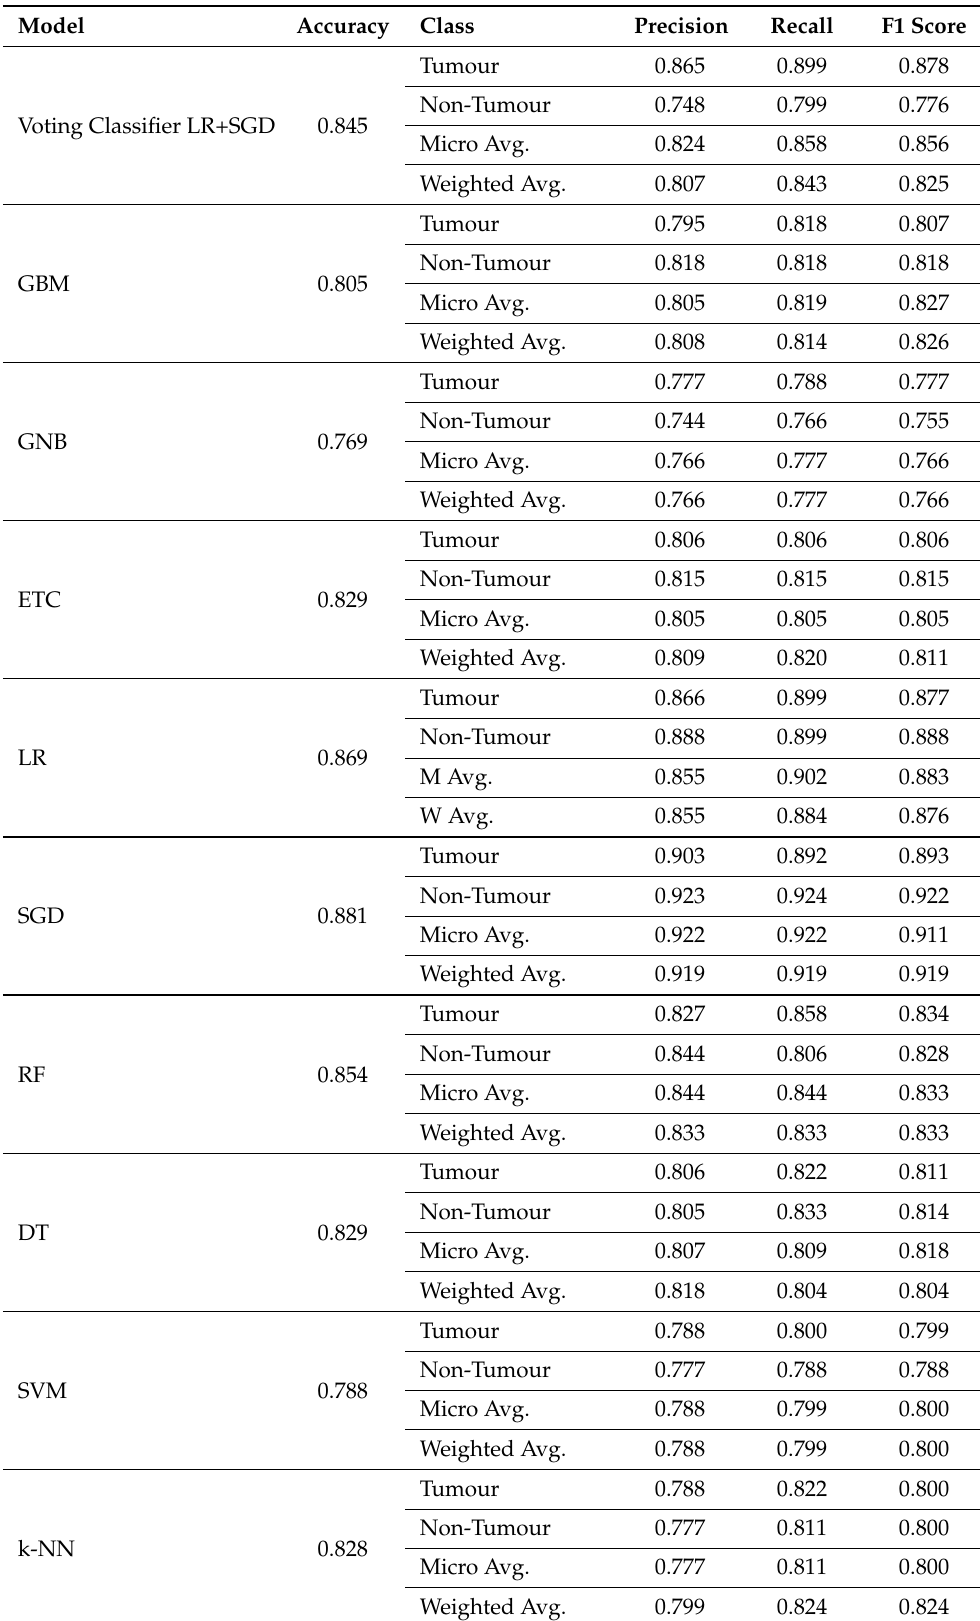
Table 2. Results of machine learning models using the original